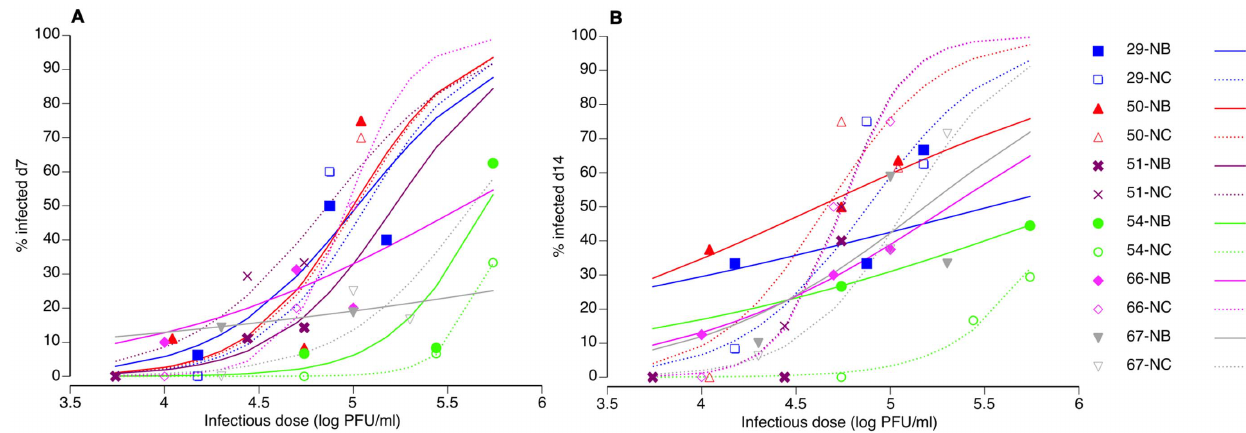
Figure 1. Logistic fits of the observed dose-responses. The percentage of mosquitoes found virus-positive 7 days ( A ) and 14 days ( B ) after oral challenge is shown as a function of the blood meal titer for all combinations of two Ae. aegypti populations (NB= Na Bo Kham; NC= Nakhon Chum) and six DENV-2 virus isolates (experiment 1: isolates 29, 54, 66 and 67; experiment 2: isolates 50 and 51). Symbols represent empirical data and lines are logistic fits of the data. Solid symbols and lines correspond to the NB population; Open symbols and dashed lines represent the NC population. Note that the logistic fit of the 51-NB pair at day 14 was omitted from the figure because parameter estimates were unstable.